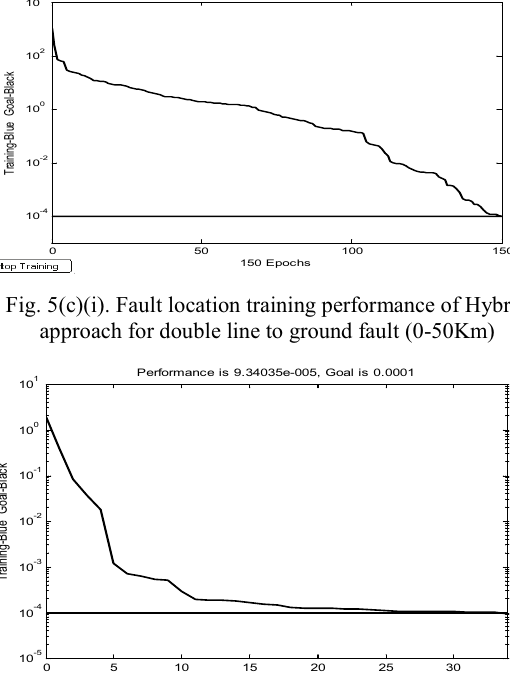
Fig. 5(d)(i). Fault location training performance of Hybrid approach for double line to ground fault (50-100Km)